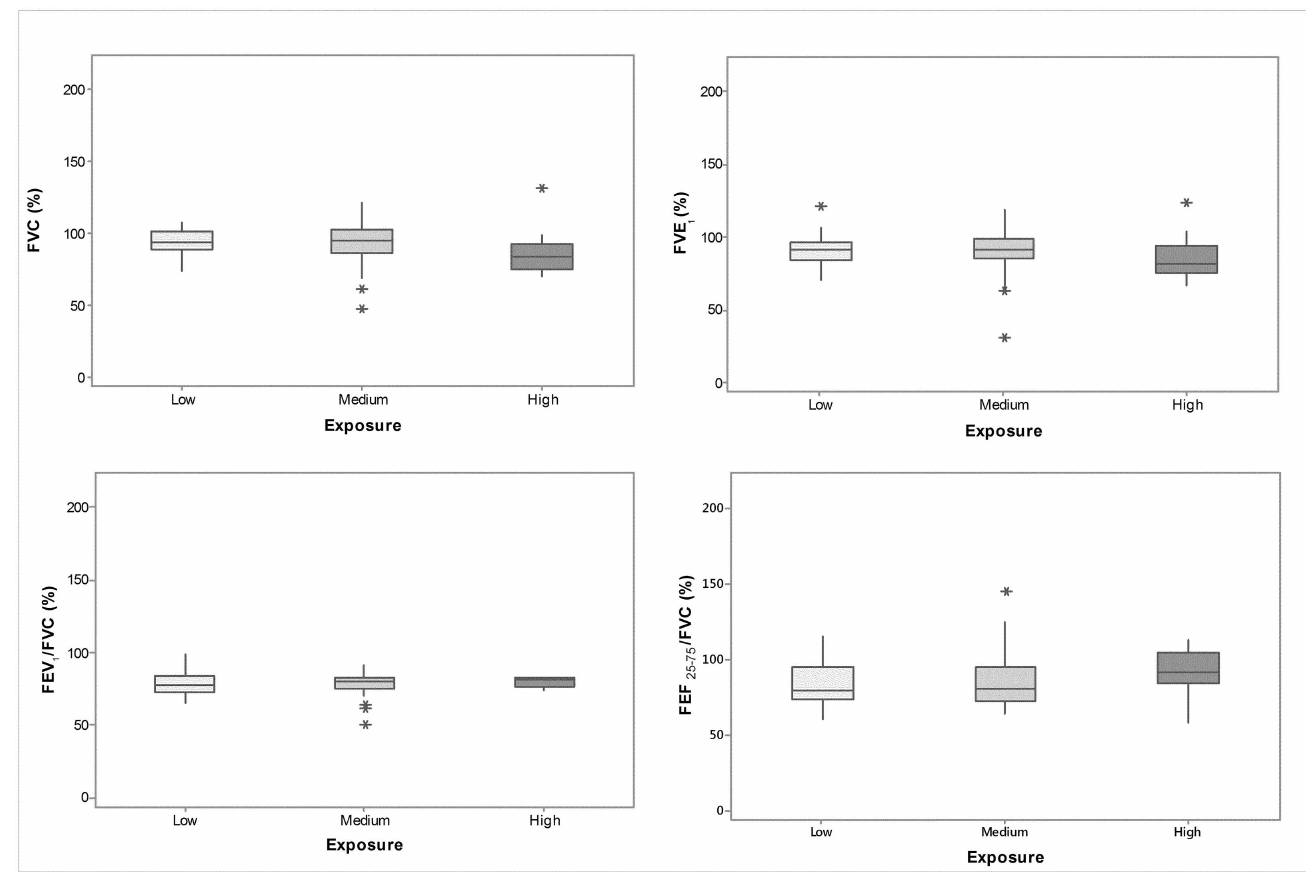
Fig 2. Box-plots of the spirometric parameters of each exposure group. The values of FVC and FEV 1 correspondto the percentageof predicted values and FEF 25-75% /FVC, and the ratio of FEV 1 /FVC was computedconsideringthe measured values.